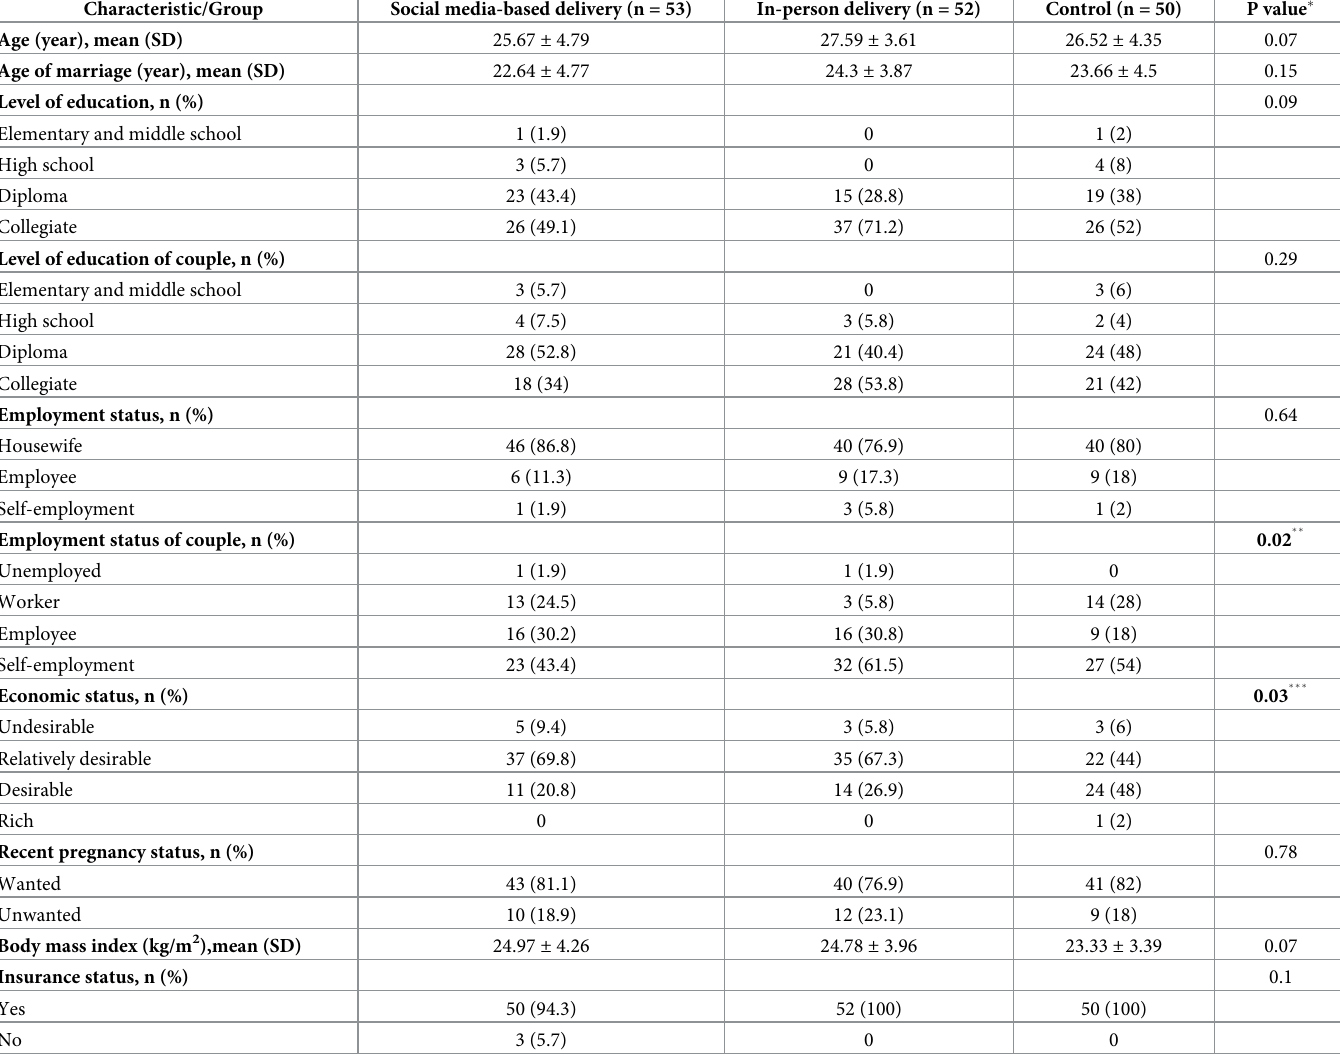
Table 2. Individual characteristics of study participants and comparisons between social media-based education through Telegram app, in-person education in childbirth preparation courses, and control groups (n = 155).